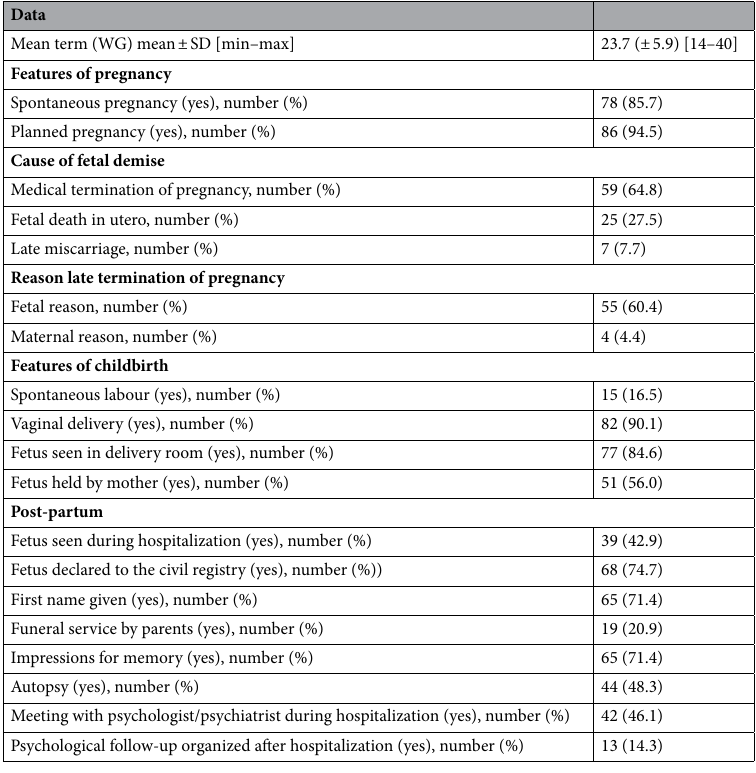
Table 2. Contextual data on fetal demise (n = 91). % percentage, SD Standard Deviation, WG weeks of gestation.